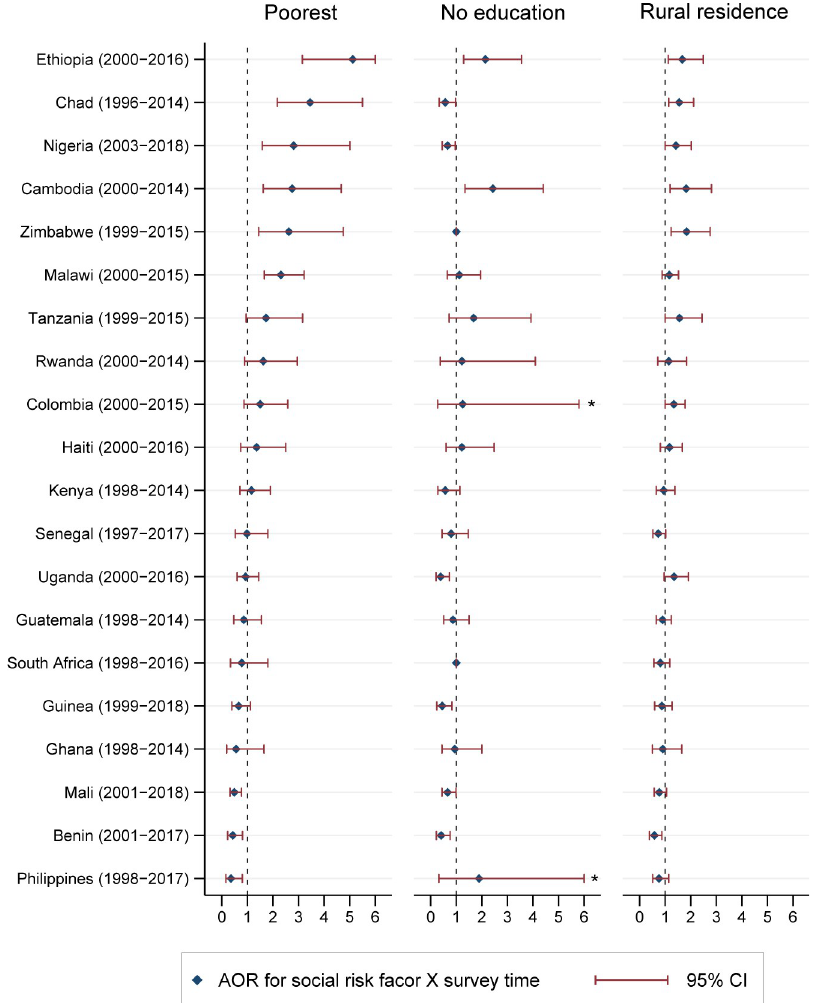
Fig 2. Transition in the social risk factor of adolescent motherhood in LMICs (AOR) during 1996–2018: Country specific estimates. � Value of upper limit of the 95% CI is > 6.0. AOR: Adjusted Odds Ratio; CI: Confidence Interval. Only coefficient of interaction terms for ‘wealth quintile’ (ref: richest), ‘level of education’ (ref: secondary or higher) and ‘area of resident’ (ref: urban residence) are presented in this figure. X represents interactions. AOR > 1 ( < 1) represents increased (decreased) in the association between adolescent mother and social risk factors at endline compared to